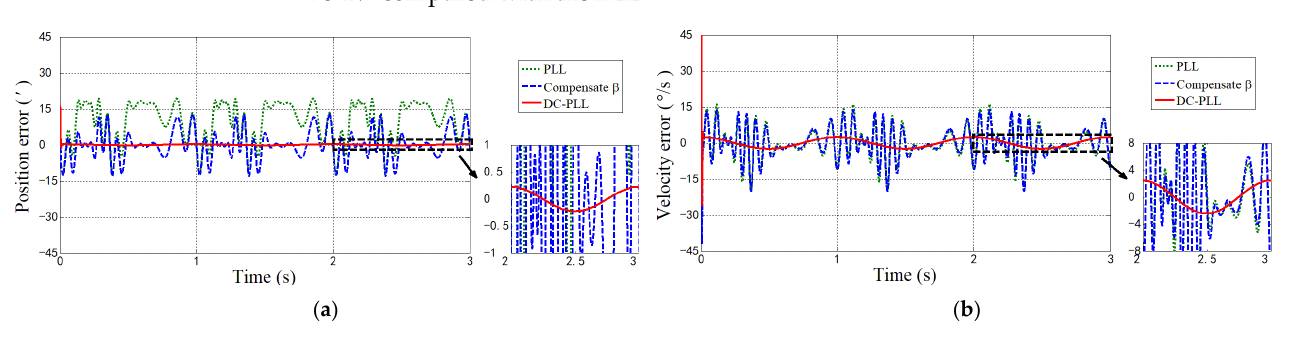
Figure 10. Demodulation errors at sinusoidal speed in simulation. ( a ) Position estimation error; ( b ) velocity estimation error.